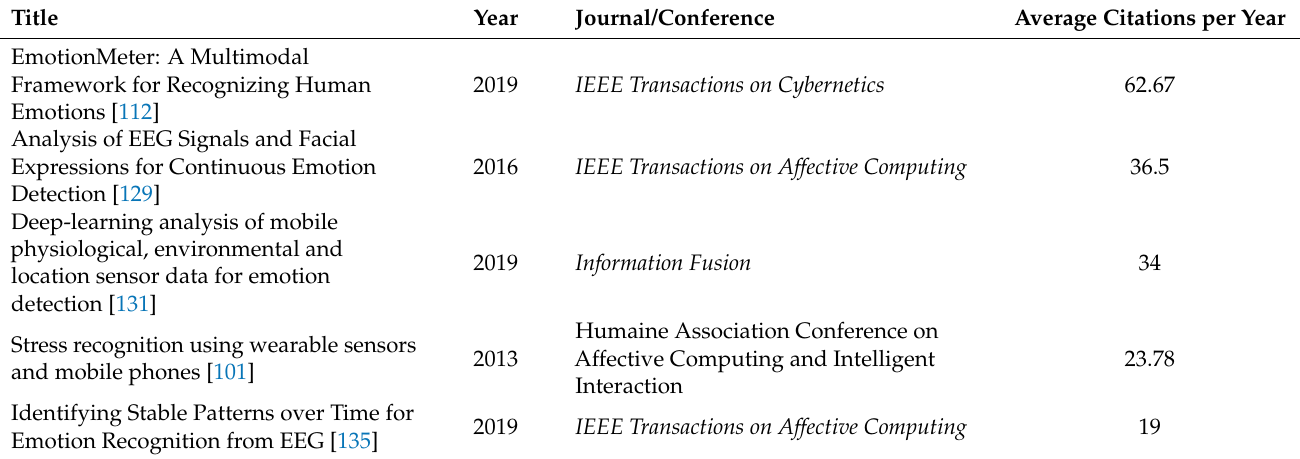
Table 8. Top ten most cited studies by the average number of paper citations per